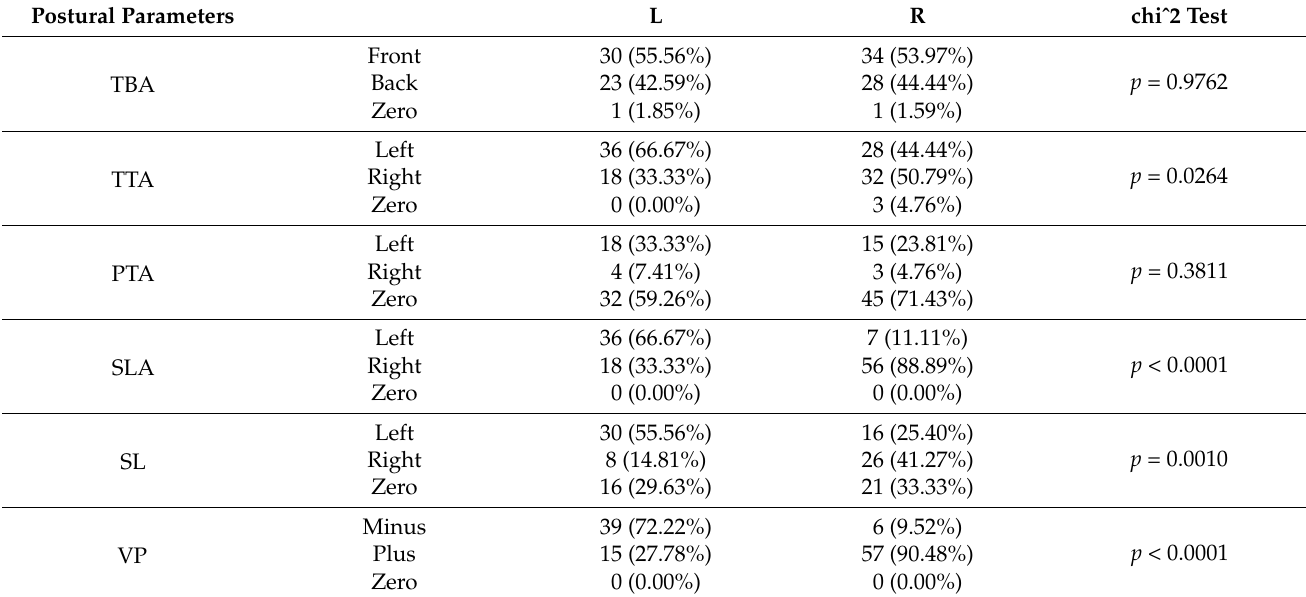
Table 3. Analysis of TBA, TTA, PTA, SLA, SL and VP in studied groups; analysis of correlations between groups and parameters in relation to the operated side (left or right).